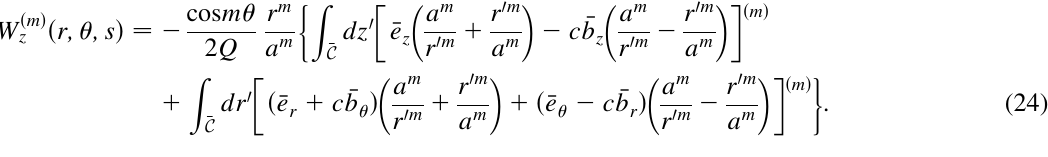
FIG. 2. (Color) The cavity and the integration path. Here we assume that the radius of the beam tube on the downstream side a . The contour L is the straight line of radius r . The contour C is arbitrary and this has radial smaller than that on the upstream side a r in and r at z (cid:1) (cid:2)1 , respectively. A loop G consists of a straight line L and arbitrary contour C and two radial lines offsets r r in out connecting between them. The sign of contour (cid:9) C means that the direction of the integration path is opposite to C . We call the contour (cid:1) C Napoly-Zotter contour. The longitudinal coordinate z and z , and the radial coordinate a specify the contour (cid:1) C 1 2 0